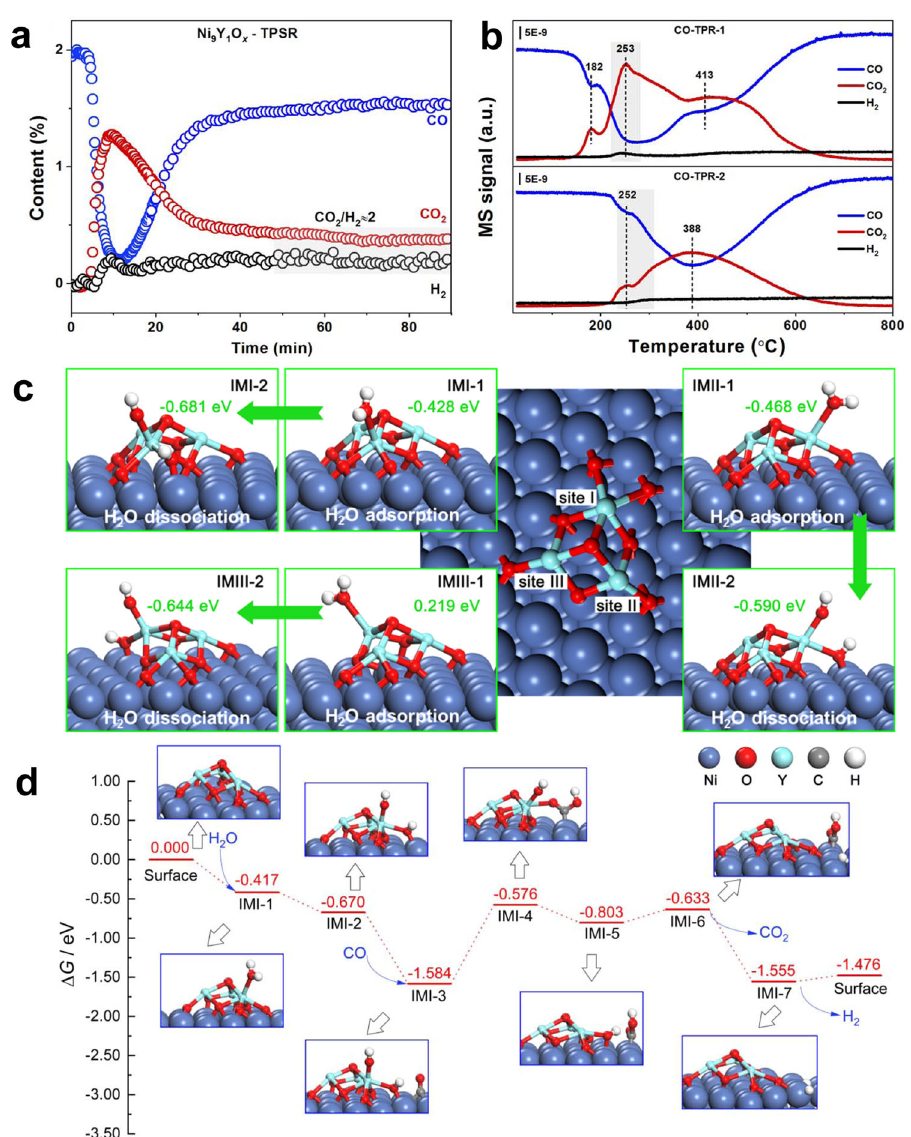
Fig. 5 The WGS mechanism study and DFT calculation of the Ni 9 Y 1 O x catalyst. a Surface reaction on the Ni 9 Y 1 O x catalyst at 250 °C under 2%CO/Ar atmosphere; b cyclic CO-TPR experiments for CO consumed and CO 2 evolved against temperature for the Ni 9 Y 1 O x catalyst (Between CO-TPR-1 and CO- TPR-2, the catalyst was treated in the WGS atmosphere at room temperature); c the Δ G of H 2 O adsorption and dissociation process at three Y atom sites in the Y 3 O 4 /NiO x /Ni{111} model, the reaction temperature was set to 300 °C and the partial pressure of water vapor was set to 10 kPa, i.e., the inlet pressure; d the simulated WGS reaction pathways (the reaction temperature: 300 °C, the partial pressure of CO, H 2 O, CO 2 and H 2 : 1, 8000, 2000 and 2000 Pa, i.e., the outlet pressure of the